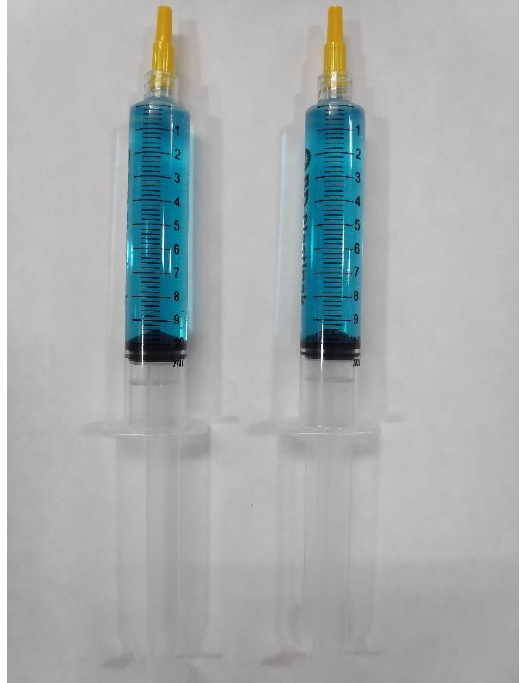
Figure 1. Representative picture of the submucosal injection solution in the syringe.